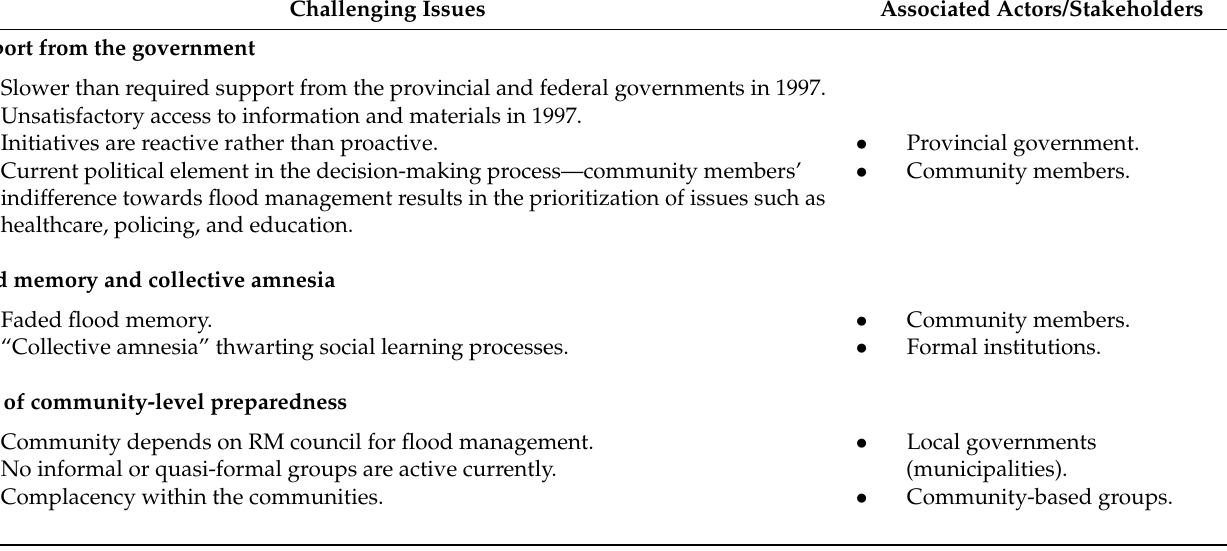
Table 5. Multilevel challenges of coping and adaptation to floods in locallevel flood management in